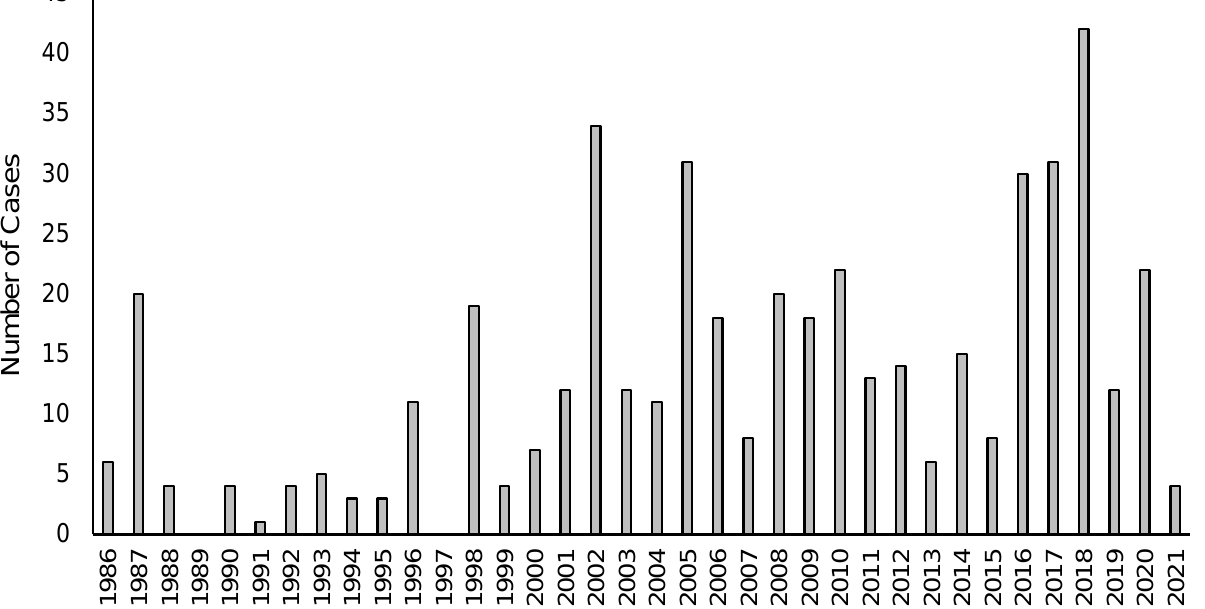
Figure 2. Total number of cases retrieved in our systematic review of the literature on in situ aerosol–PBAP research in Brazil distributed by year of publication, from 1986 until 31 December 2021.